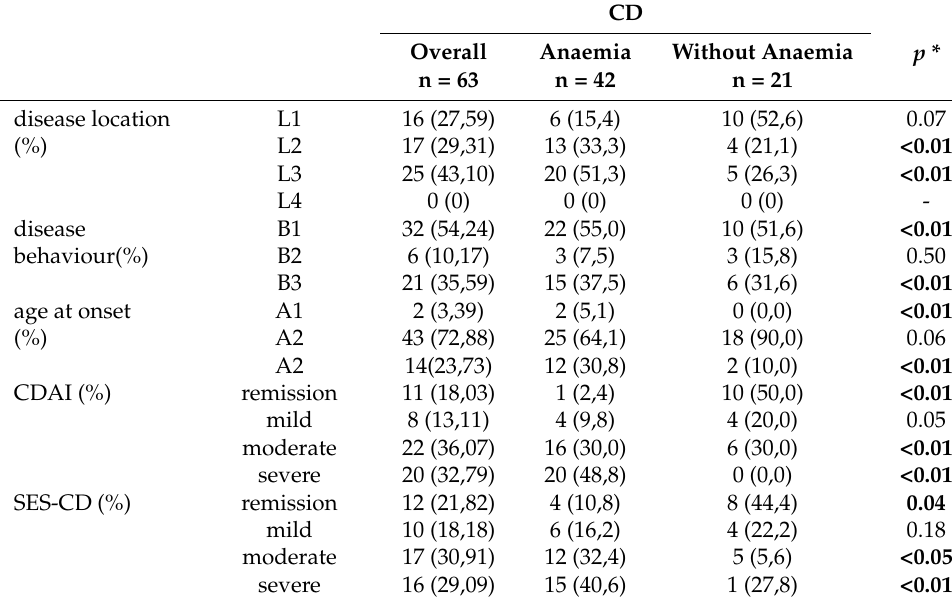
Table 2. Clinical characteristics of patients with CD with and without anaemia.